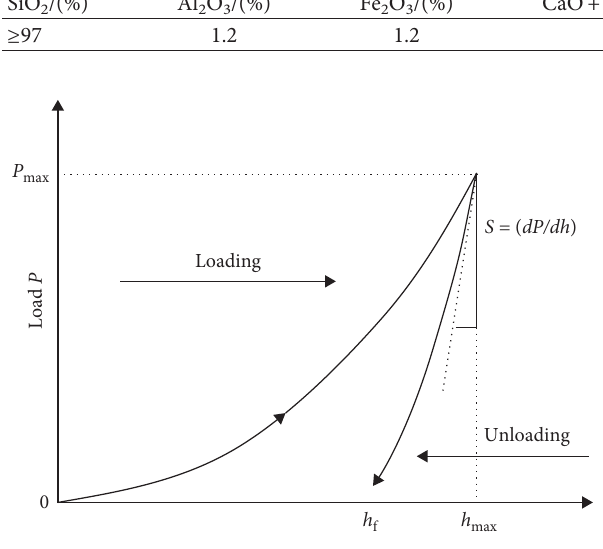
Figure 1: A typical load-depth